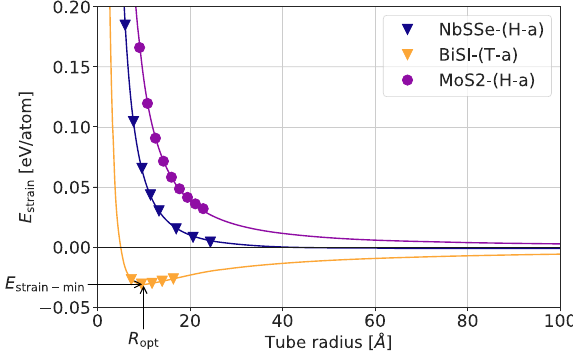
Fig. 2 Strain energy as a function of the nanotube radius. Strain energy as a function of the radius for the symmetric MoS 2 nanotube and the two asymmetric NbSSe and BiSI nanotubes. The label in brackets indicates the prototype (H-/T-phase) and the wrapping direction (a/z indicating